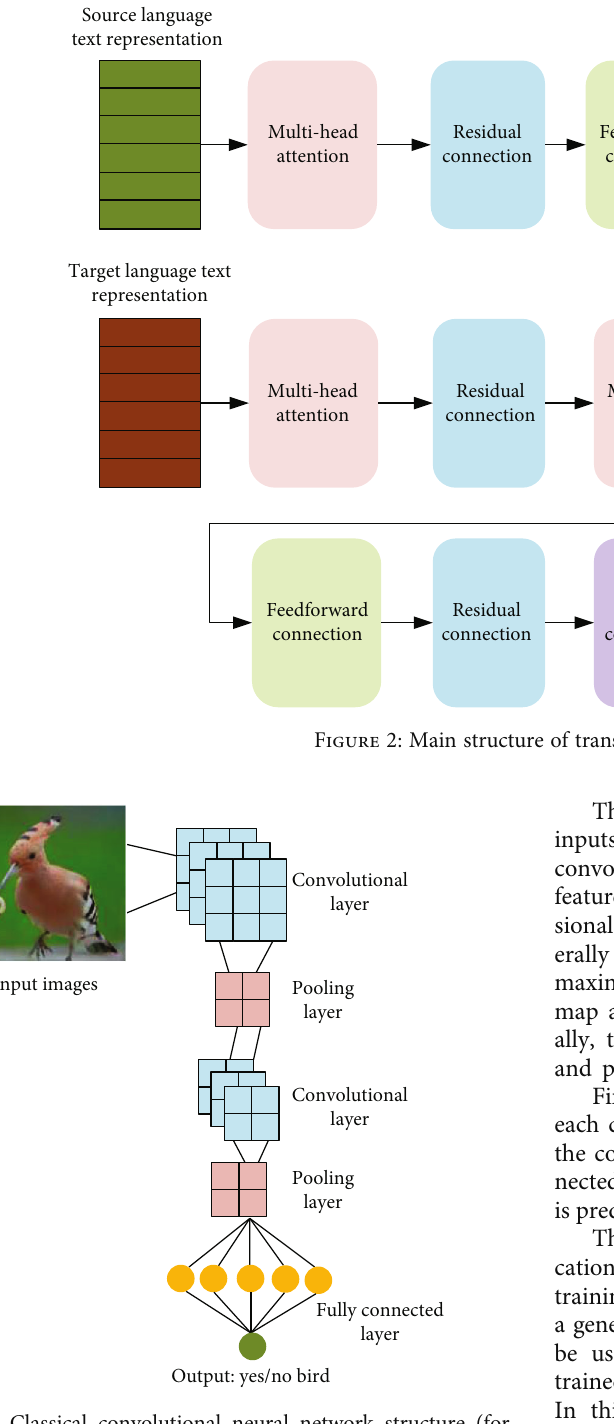
Figure 3: Classical convolutional neural network structure (for recognizing multimedia information such as